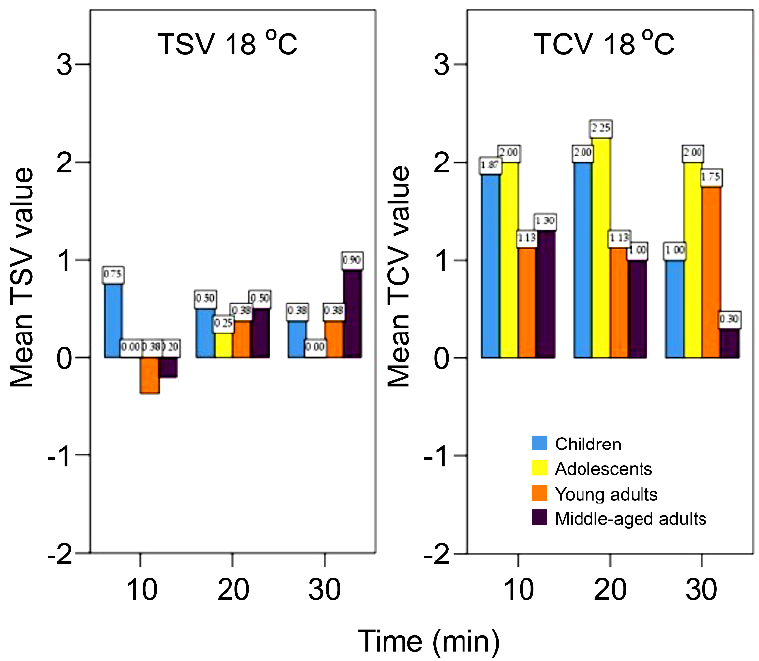
Figure 11. Comparison of the mean TSV and TCV of participants (18 °C).